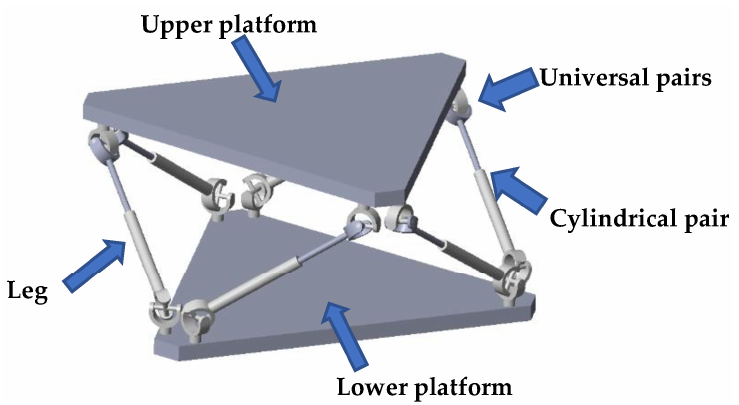
Figure 9. The configuration and structure of the cube Stewart platform.